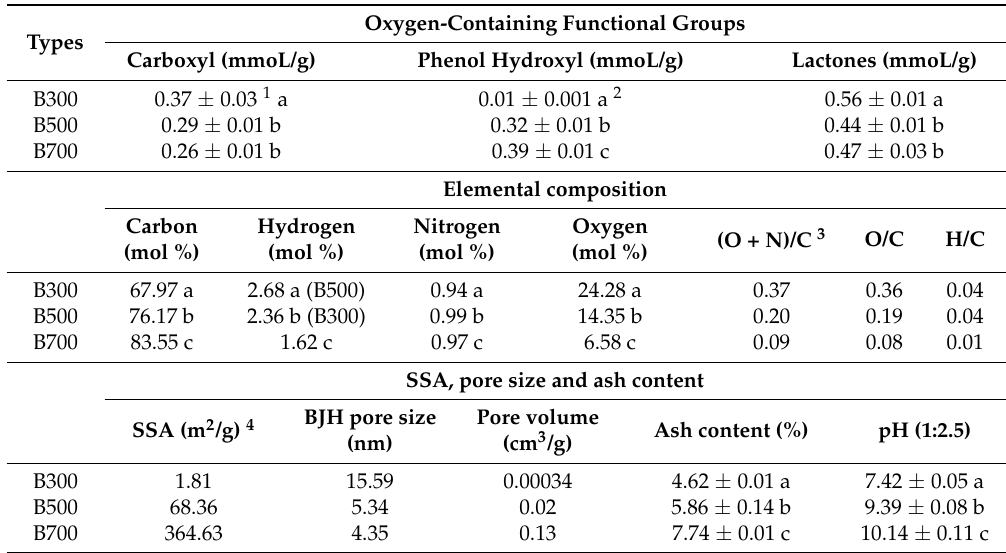
Table 1. Characteristics of biochar produced at different temperatures.